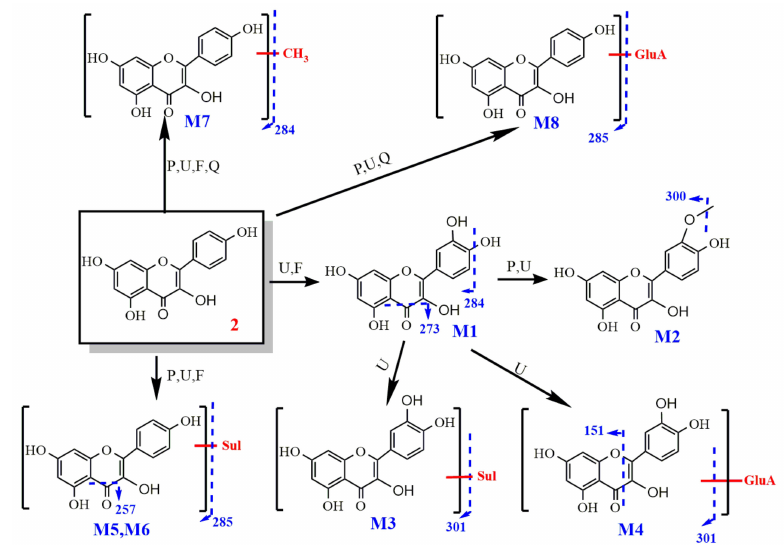
Figure 8. The metabolic pathway of kaempferol.